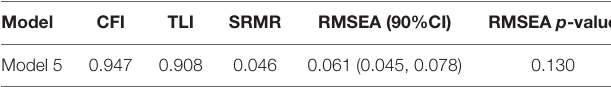
TABLE 4 | Model Fit Indices for model of final structural model.